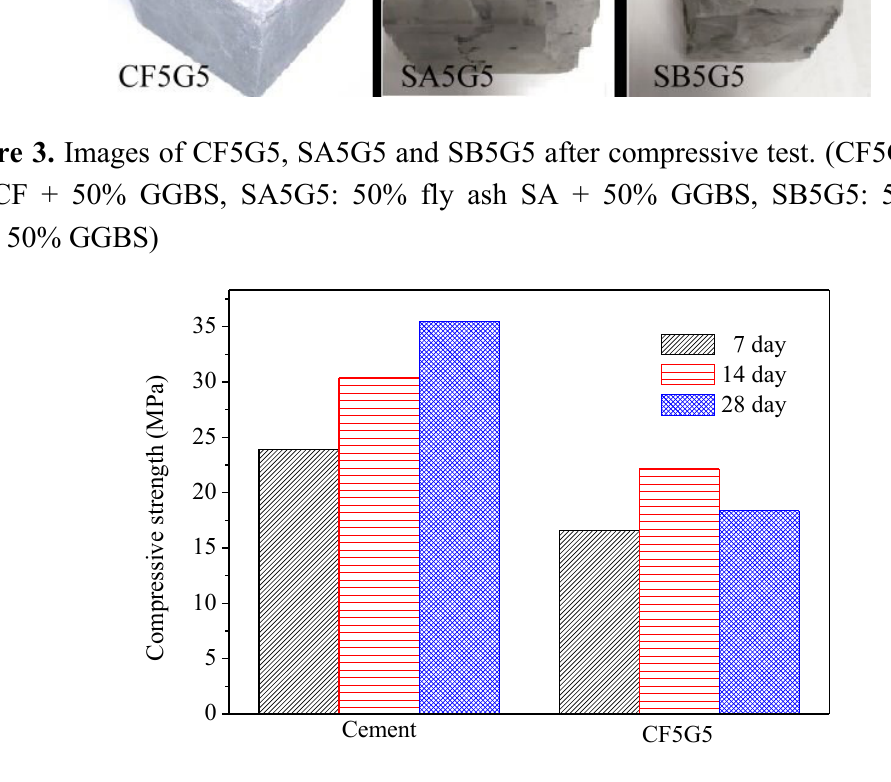
Figure 4. Compressive strength of co-firing fly ash and GGBS blended cement mortar. (GGBS: ground granulated blast-furnace slag, CF5G5: 50% fly ash CF + 50% GGBS)